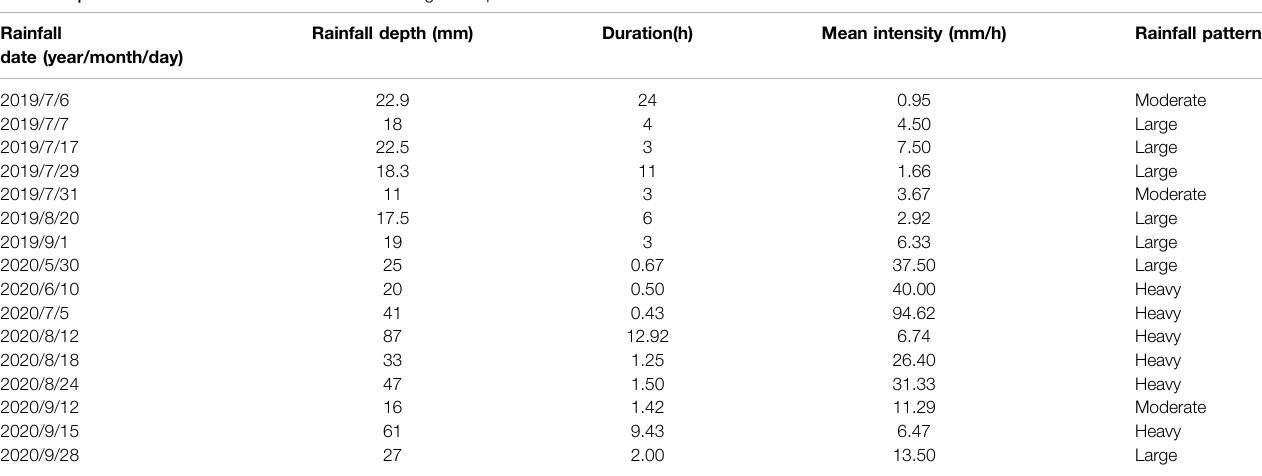
TABLE 1 | Rainfall characteristic for erosive events during the